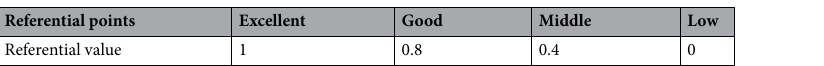
Table 2. The output power of the PV power generation system.